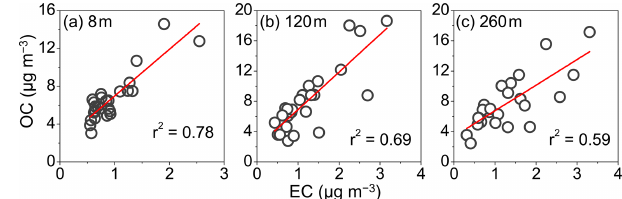
Figure 3. Correlations between OC and EC at ground level, 120m and